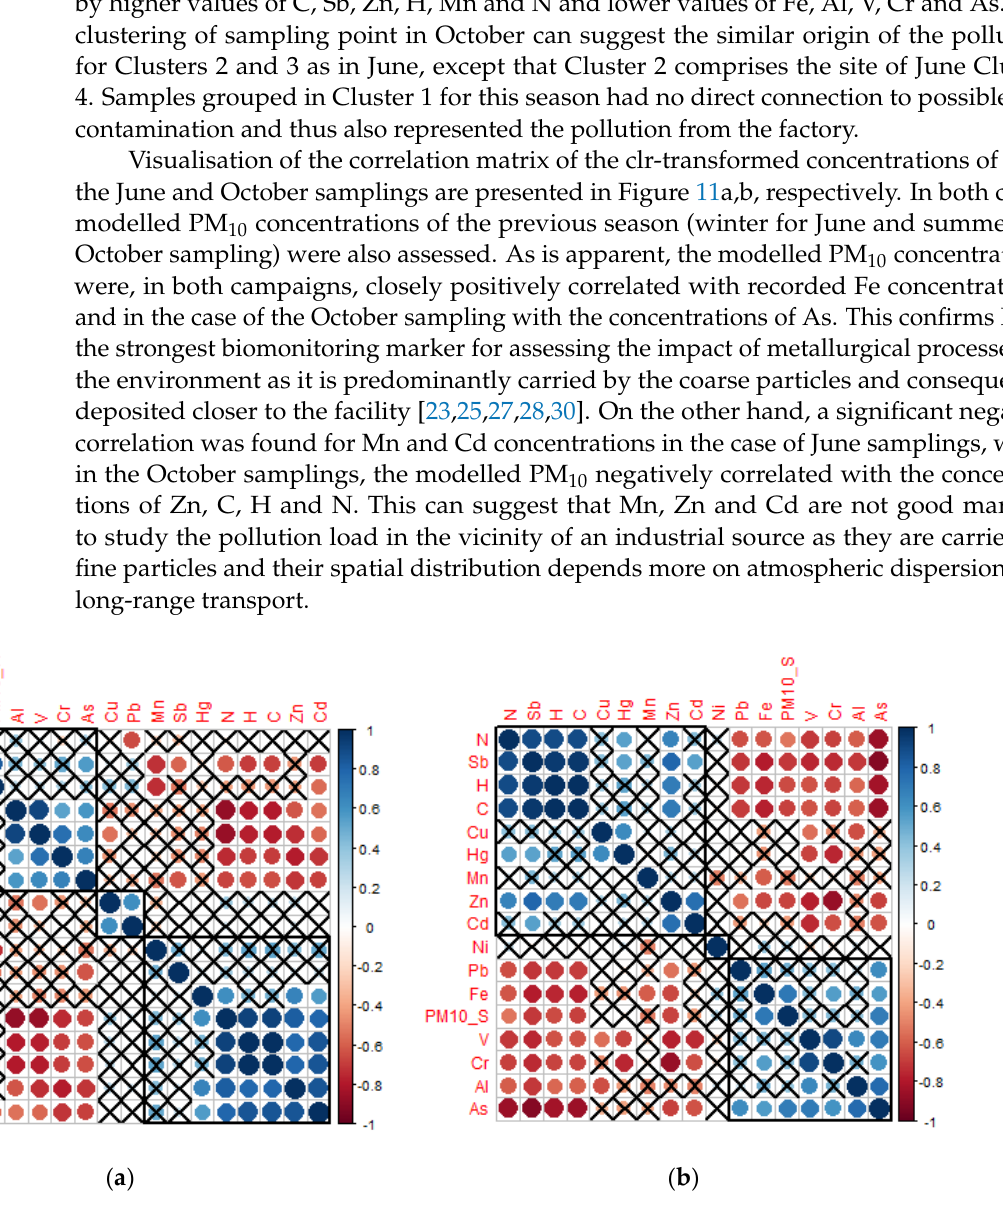
Figure 11. Correlation plot of June sampling ( a ) and October sampling ( b ). Size of the point indicates the strength of the correlation, blue—positive, red—negative correlation; crossed points indicate the non-significant correlations.